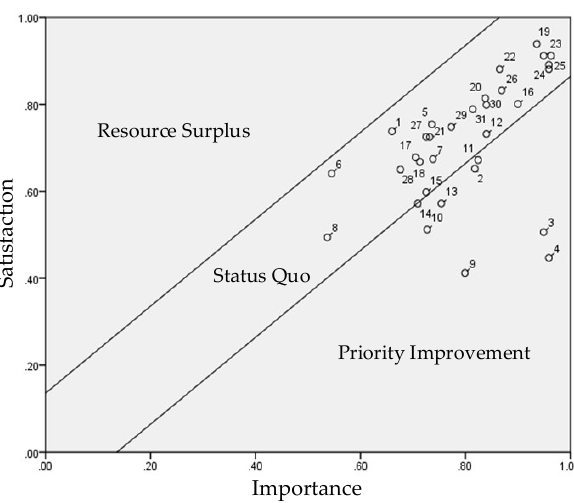
Figure 6. Performance Evaluation Matrix (PEM) of the Female Respondents.